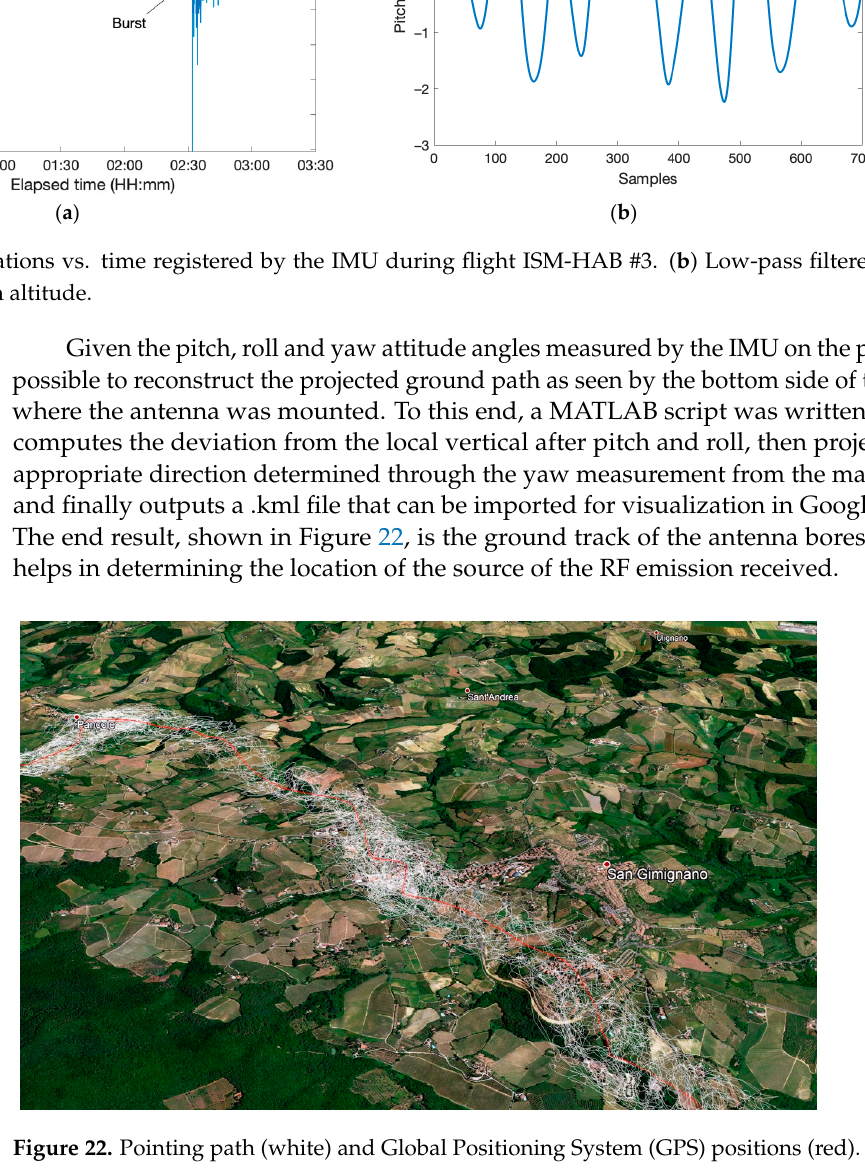
Figure 22. Pointing path (white) and Global Positioning System (GPS) positions